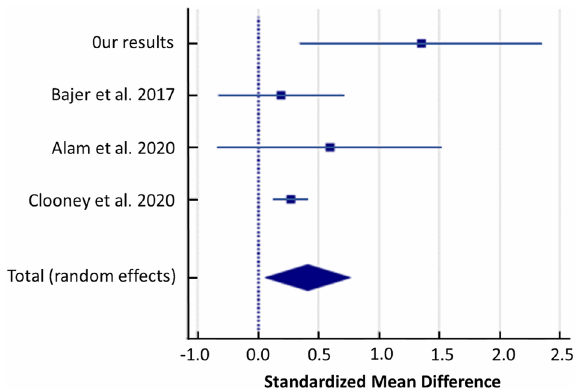
Figure 7. Forest plot of random-effects meta-analysis including studies evaluating the abundance of Streptococcaceae in UC patients versus healthy controls.